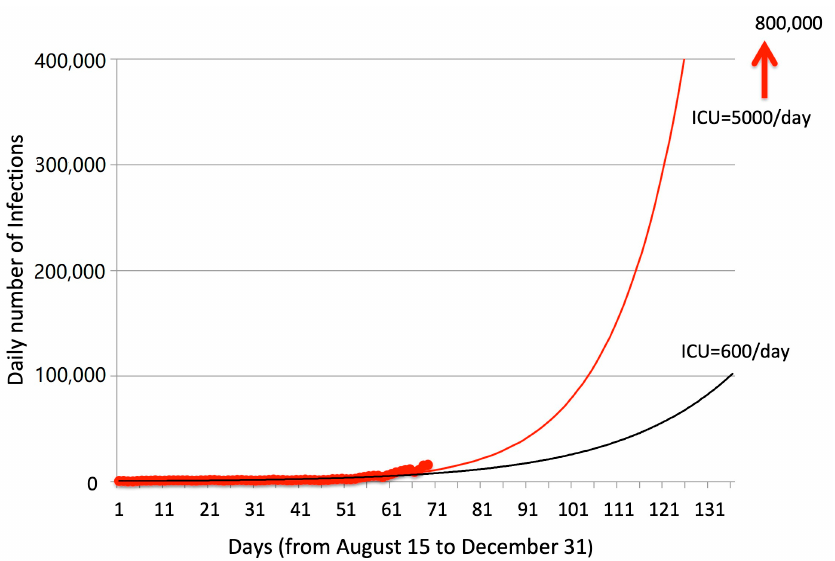
Figure 5. Extrapolated exponential curves for daily infection data since August 15th to October 23rd (red circles). The best fitting exponential curve for all data is shown by the black line; red line shows the best fitting curve using only data since September 15th to October 23rd.